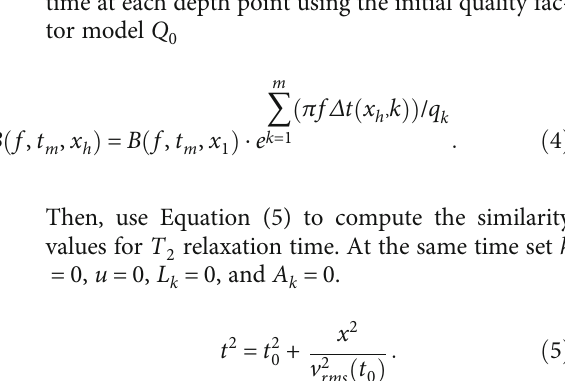
Table 2: Statistical tables of surface porosity, secondary surface porosity, and total porosity by logging interpretation of 25 casting thin sections in well DF51. No. Depth (m)